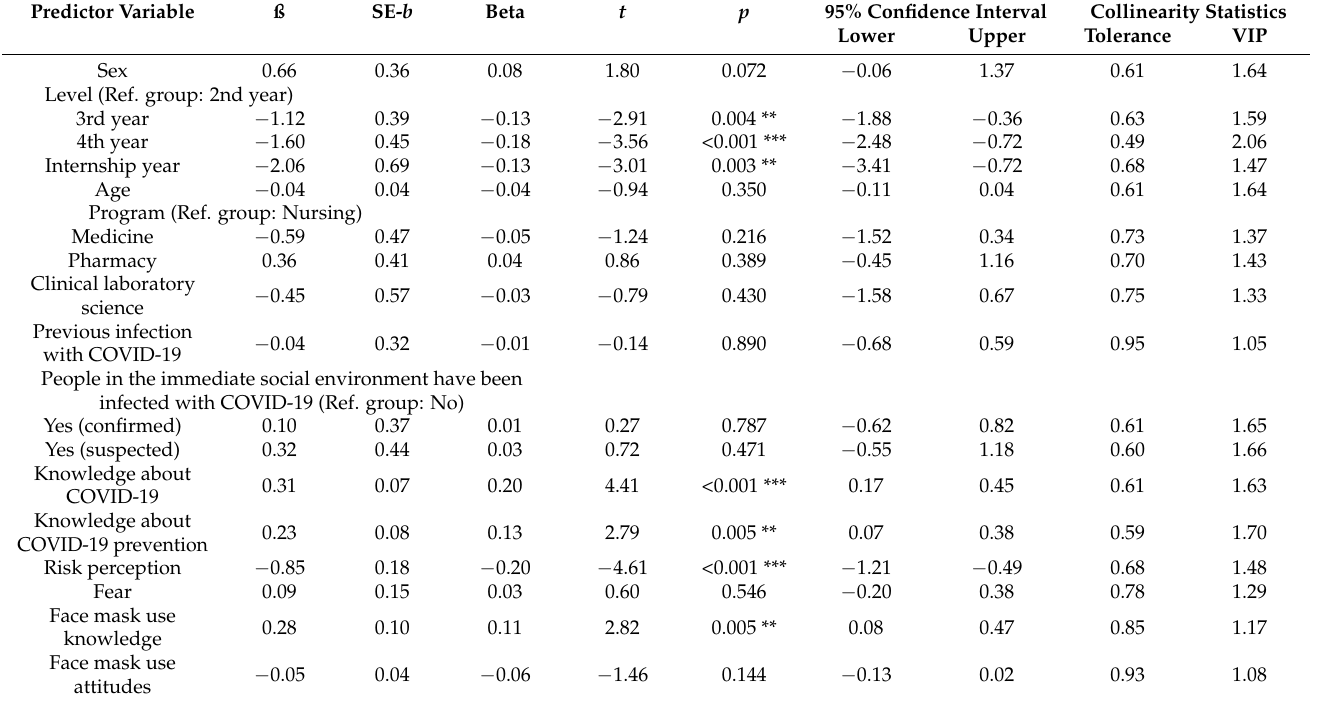
Table 4. Results of the multiple regression analysis on the students’ face mask use practice (n =